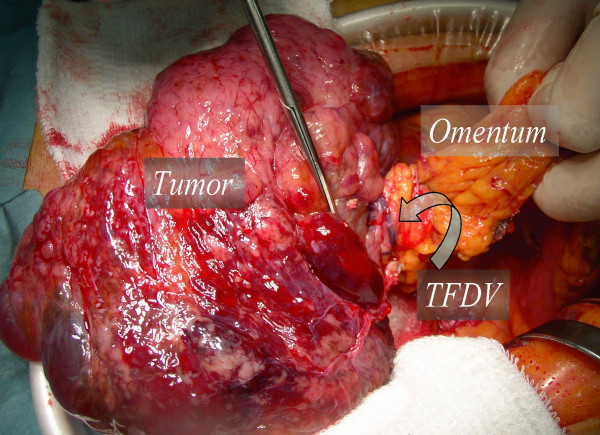
Intra-operative photograph. Scissors indicate major tumor-feeding vessels (TFDV).